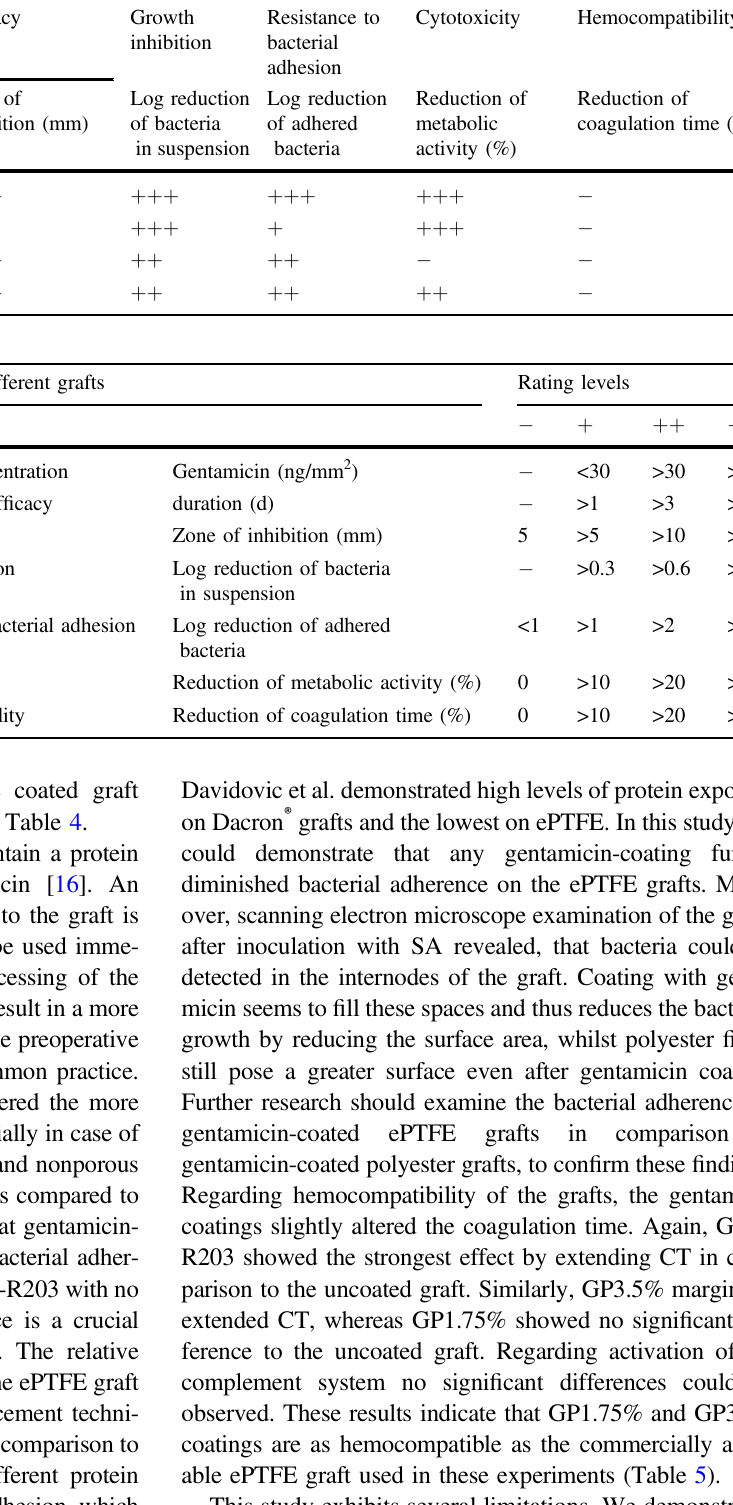
Table 4 Evaluation of the different types of gentamicin-coated ePTFE grafts Type of graft Antibiotic concentration